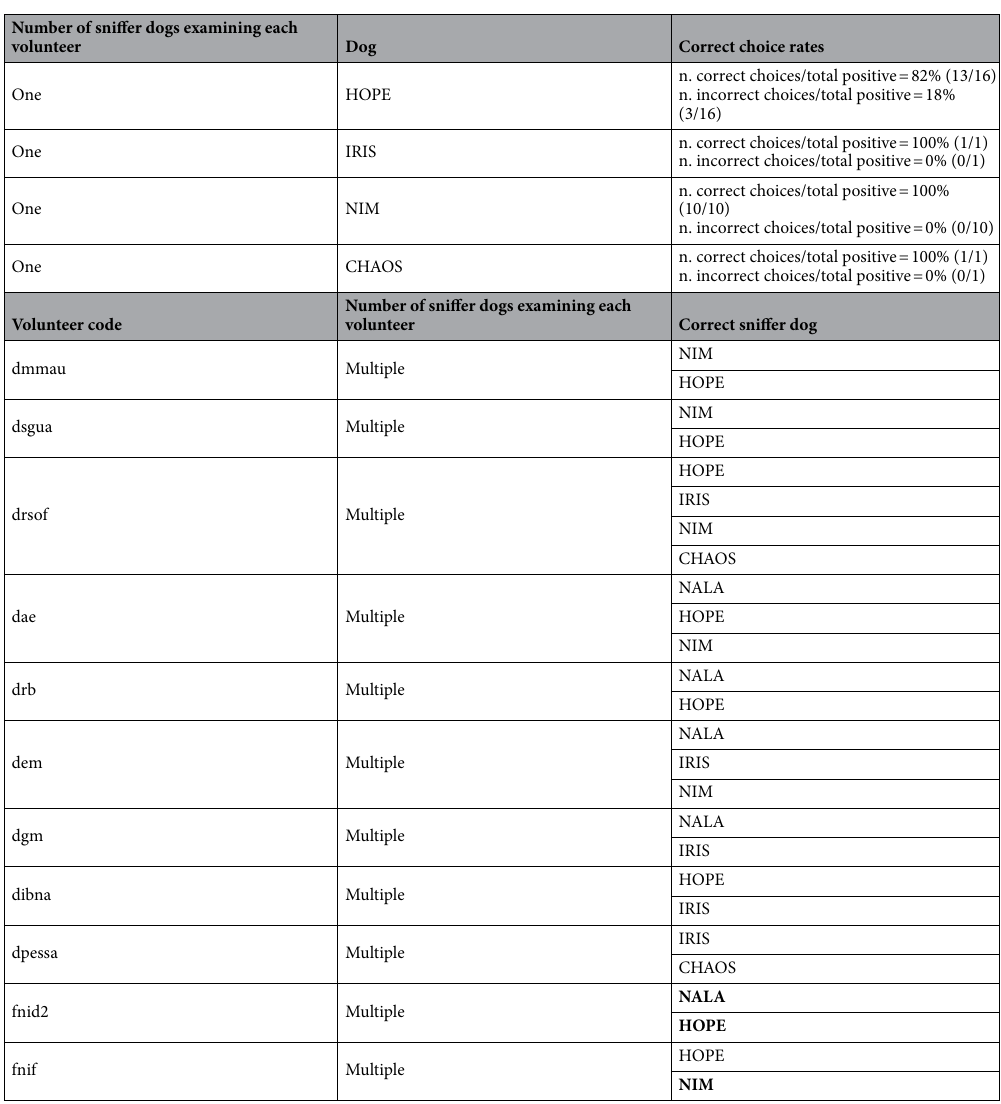
Table 4. Summary of results from volunteers who tested positive on the rapid antigen test (RAD) and were sniffed by the sniffer dogs in the field work, grouped based on being sniffed by a single dog (one) or multiple dogs (multiple). Names of sniffer dogs with wrong choices are displayed in